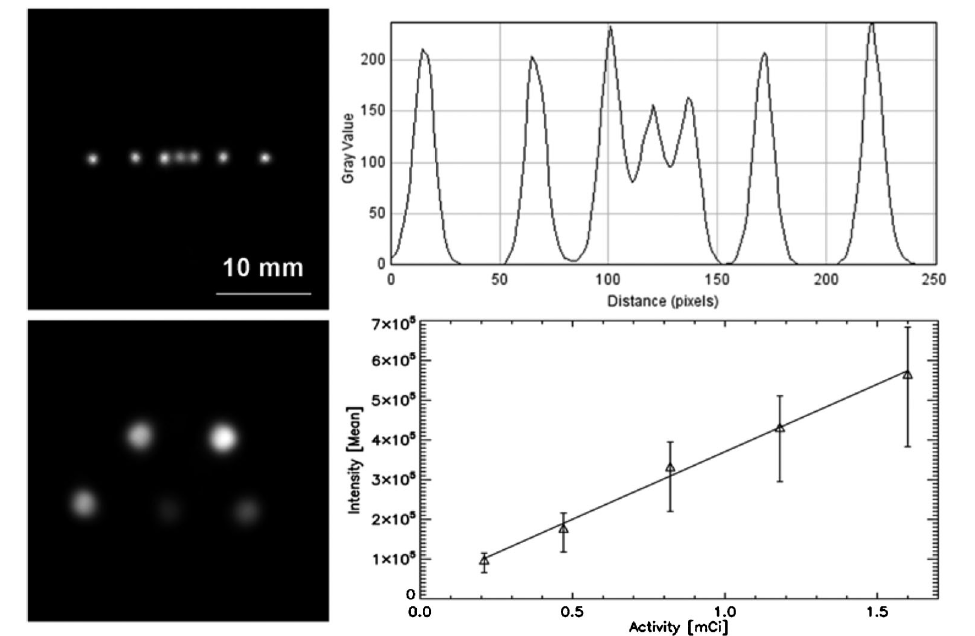
Figure 2. Spatial resolution and quantification. Upper panels , capillary tube phantom. Left : characteristic slice through the volumetric reconstruction of the phantom’s emission. Right : intensity profile along a line intersecting the seven capillaries. It can be seen that all the capillary’s emissions are well identified. Lower panels , quantification phantom. Left : characteristic slice through the volumetric reconstruction of the phantom’s emission. Right : plot of the activity in the phantom versus mean intensity in the